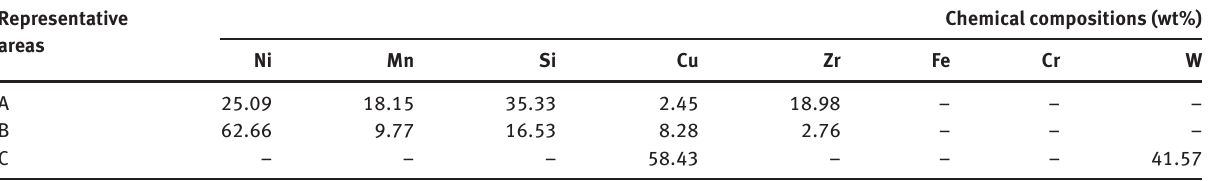
Table 6: Chemical compositions of representative areas of NiMnSiCuZr fracture surface. Representative